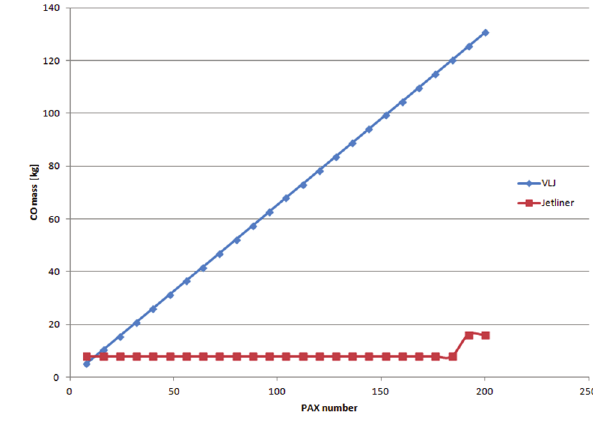
Fig. 4. Comparison between VLJ and jetliner’s CO total emission per number of passengers Analyzing the results considering NO emission, as it x can be noticed (Fig. 5) according to NO emission it is x better for ecological reasons to fly 8 VLJ with 8 people each than one jetliner with the same number of people on